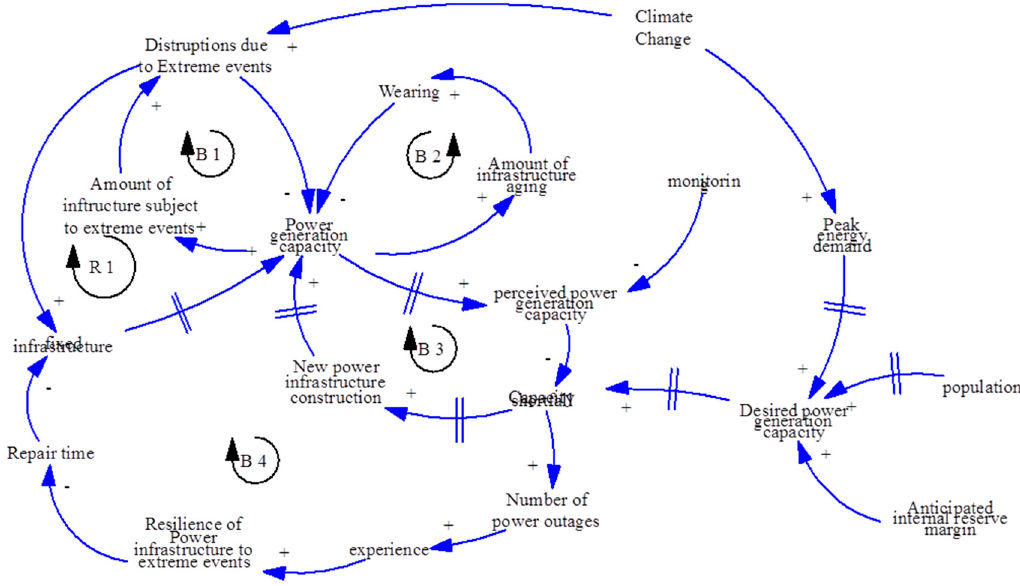
Figure 4. Causal loop diagram of the system.